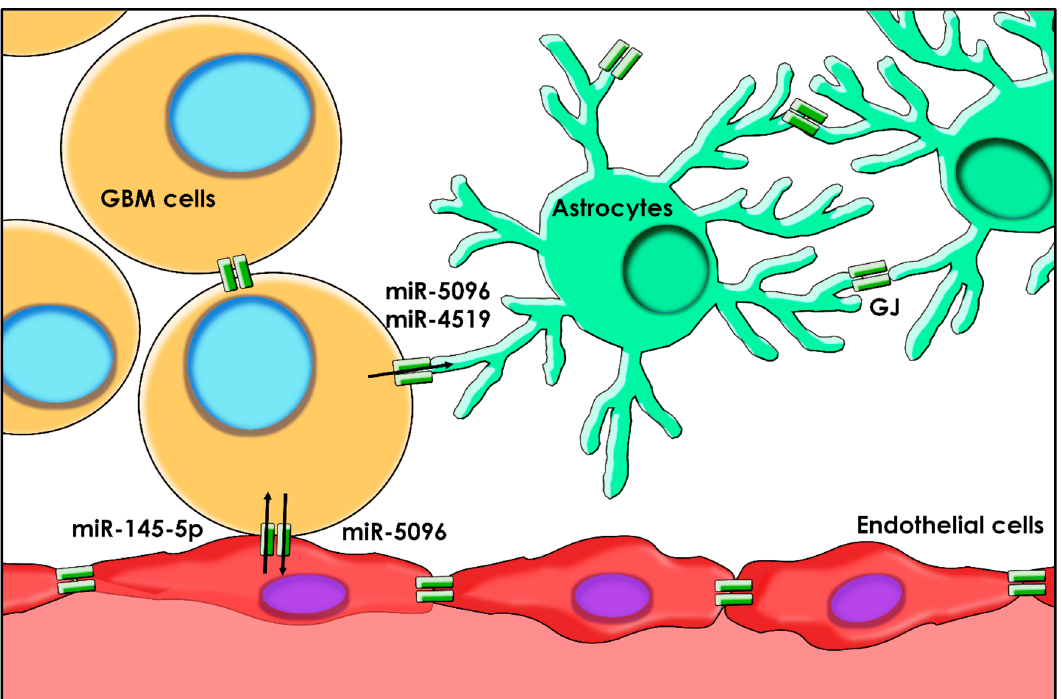
Figure 3. Glioblastoma cell—astrocyte—endothelial cell exchanging miRNAs via gap junctions (GJs): miR-5096 and miR-4519 are transferred from glioblastoma (GBM) cells to astrocytes and favors astrocyte recruitment to support tumor formation. The same miR-5096 is exchanged with miR-145-5p from the endothelial cell, promoting angiogenesis.